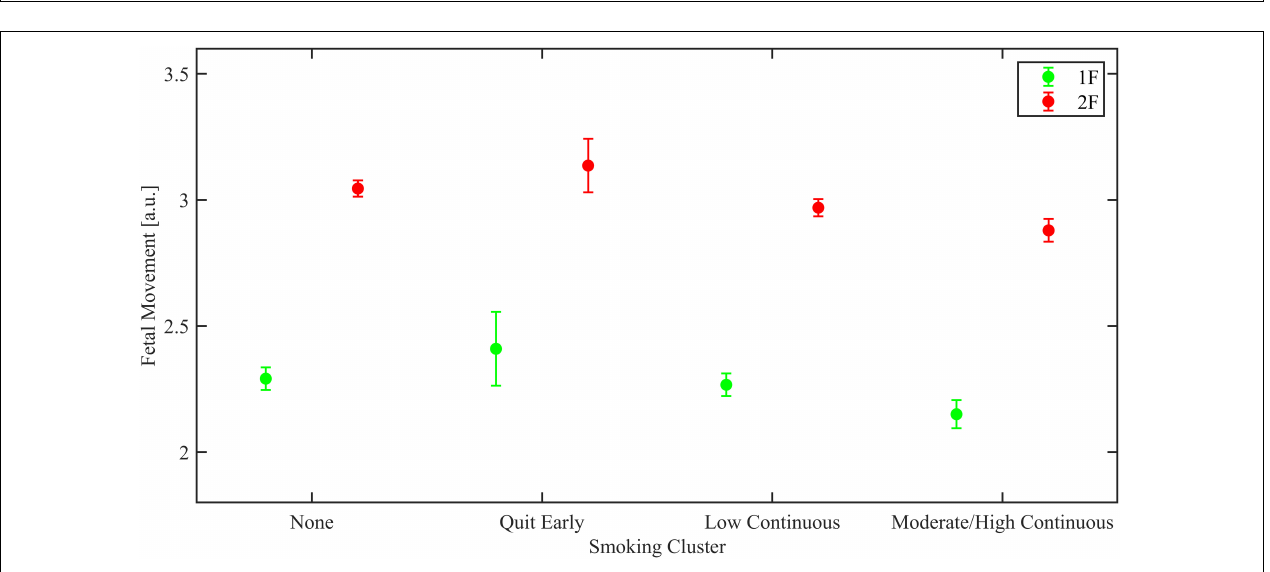
FIGURE 2 | Estimated marginal means from linear regression models of mean fetal movement, shown for the overall population by fetal behavioral sleep state (green 1F and red